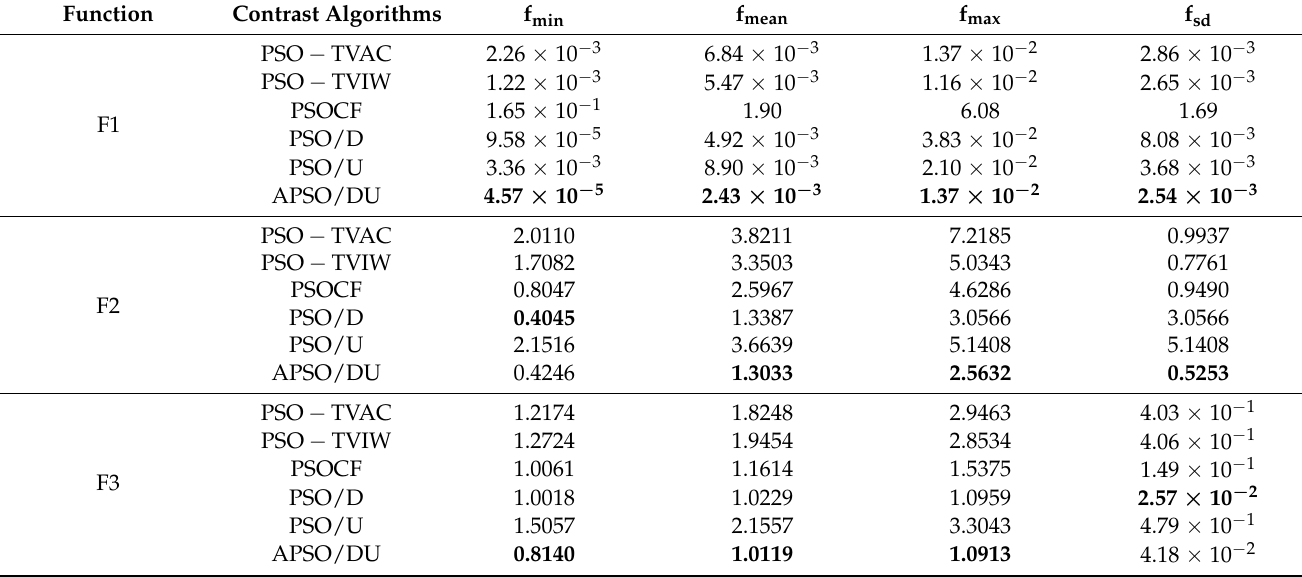
Table 3. Optimization results of six